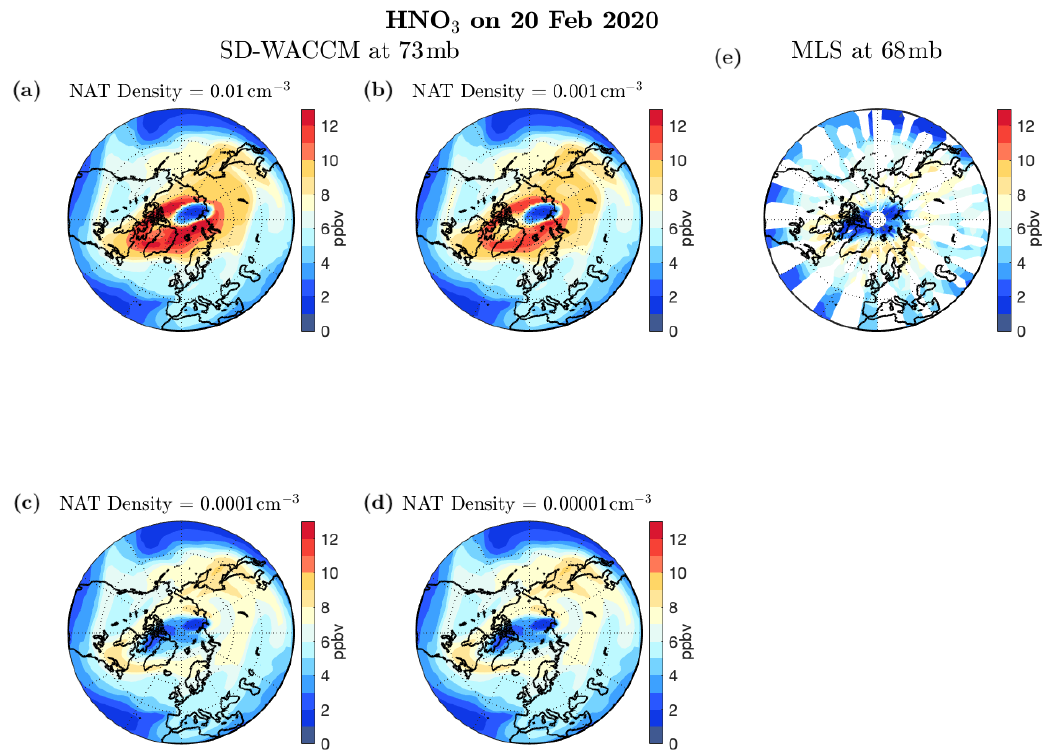
Figure 3. HNO 3 in parts per billion by volume, for 20 February 2020, for different NAT parameterizations in SD-WACCM (a–d ) compared to MLS (e) . In order of increasing denitrification, the NAT density is (a) 0.01cm − 3 , (b) 0.001cm − 3 , (c) 0.0001cm − 3 , and (d) 0.00001cm − 3 . Panel (a) shows the previous standard SD-WACCM parameterization, and panel (d) shows the chosen parameter value used in the RW and WA simulations. All SD-WACCM figures show the 73mb level; MLS (e) shows the 68mb